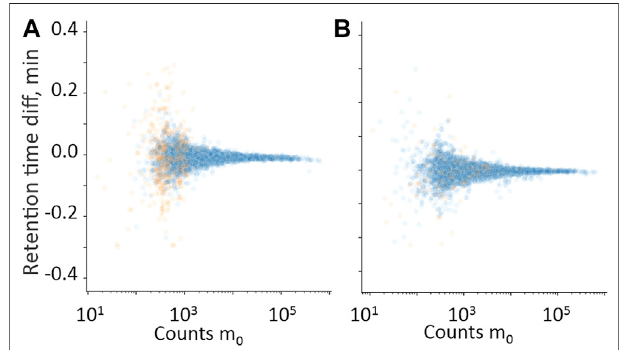
FIGURE 4 | Difference in the retention time domain between measured m 0 and measured isotopes m 1 (A) and m 2 (B) , plotted against m 0 in the (cid:129) intensity count domain. Hits from samples with positive quantitative results; (cid:129) Hits from samples with negative quantitative results.